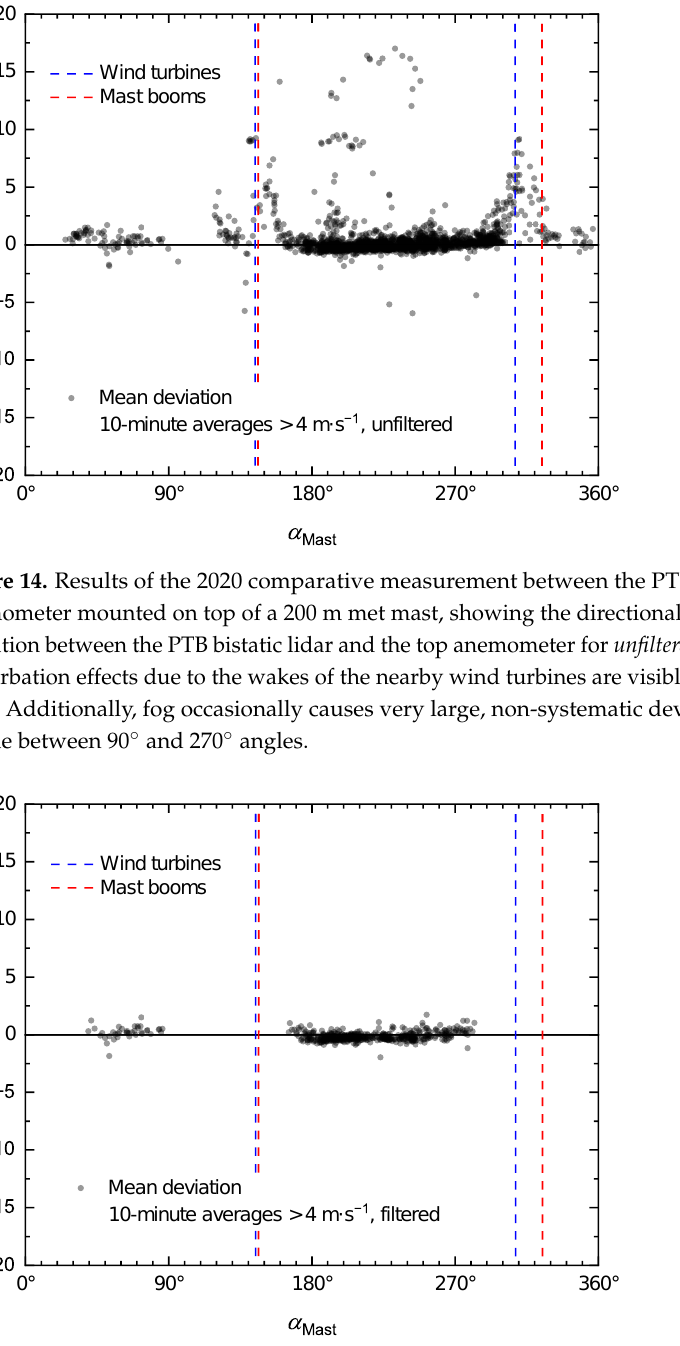
Figure 15. Results of the 2020 comparative measurement between the PTB bistatic lidar and a cup anemometer mounted on top of a 200 m met mast, showing the directional dependence of mean deviation between the PTB bistatic lidar and the top anemometer for filtered 10 min averages. Perturbation effects due to the wakes of the nearby wind turbines have been reduced by directional filtering. Furthermore, periods of fog were excluded from the